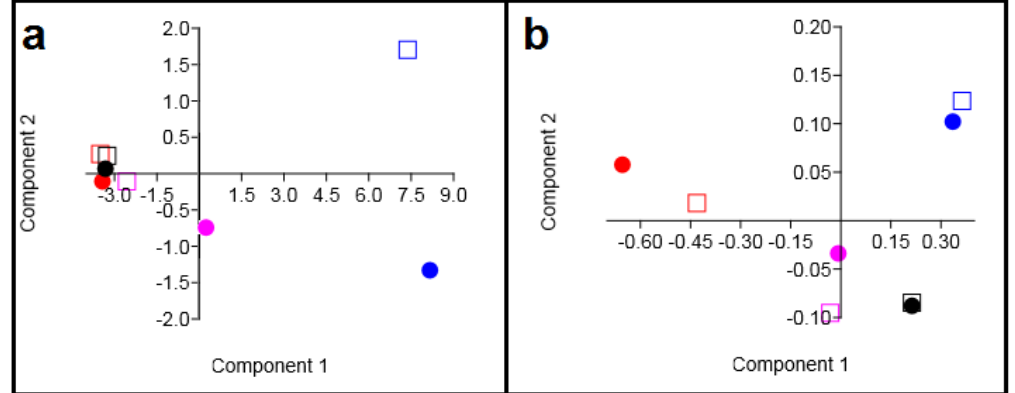
Figure 8. Principle component analysis of HCT116 (violet), LoVo (blue), SW480 (red), and SW620 (black) cell lines (dot) and their corresponding, released TMVs (square). Two-dimensional (2D) score plots of the cell line samples presented for the spectroscopy data: Raman ( a ) and FTIR ( b ). Table 3. Discriminant analysis results using PCA-LDA and leave-one-out cross validation to distinguish between the obtained